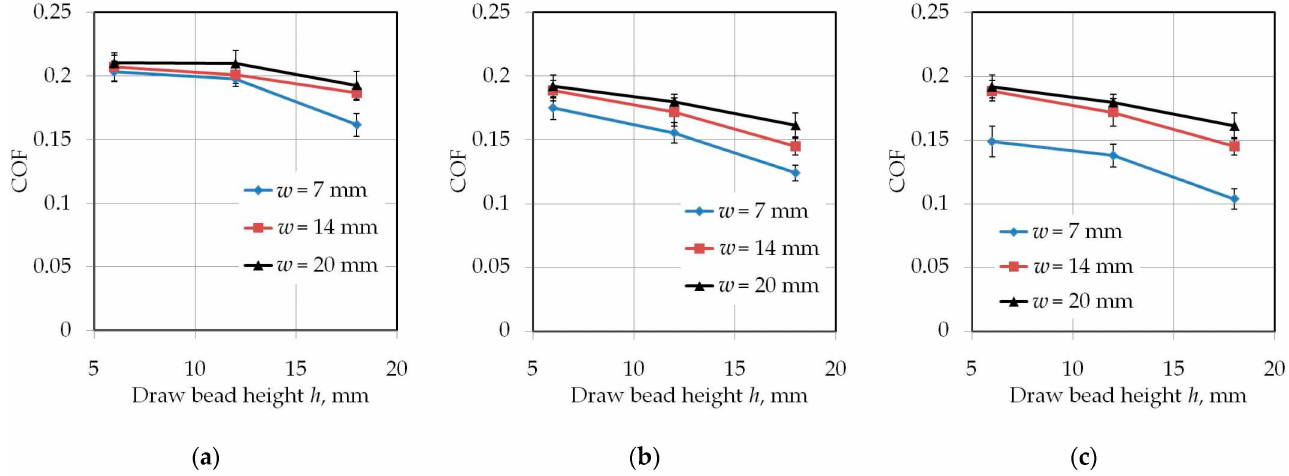
Figure 7. The effect of the drawbead height on the value of COF for specimens cut along the RD (orientation 0 ◦ ): ( a ) dry